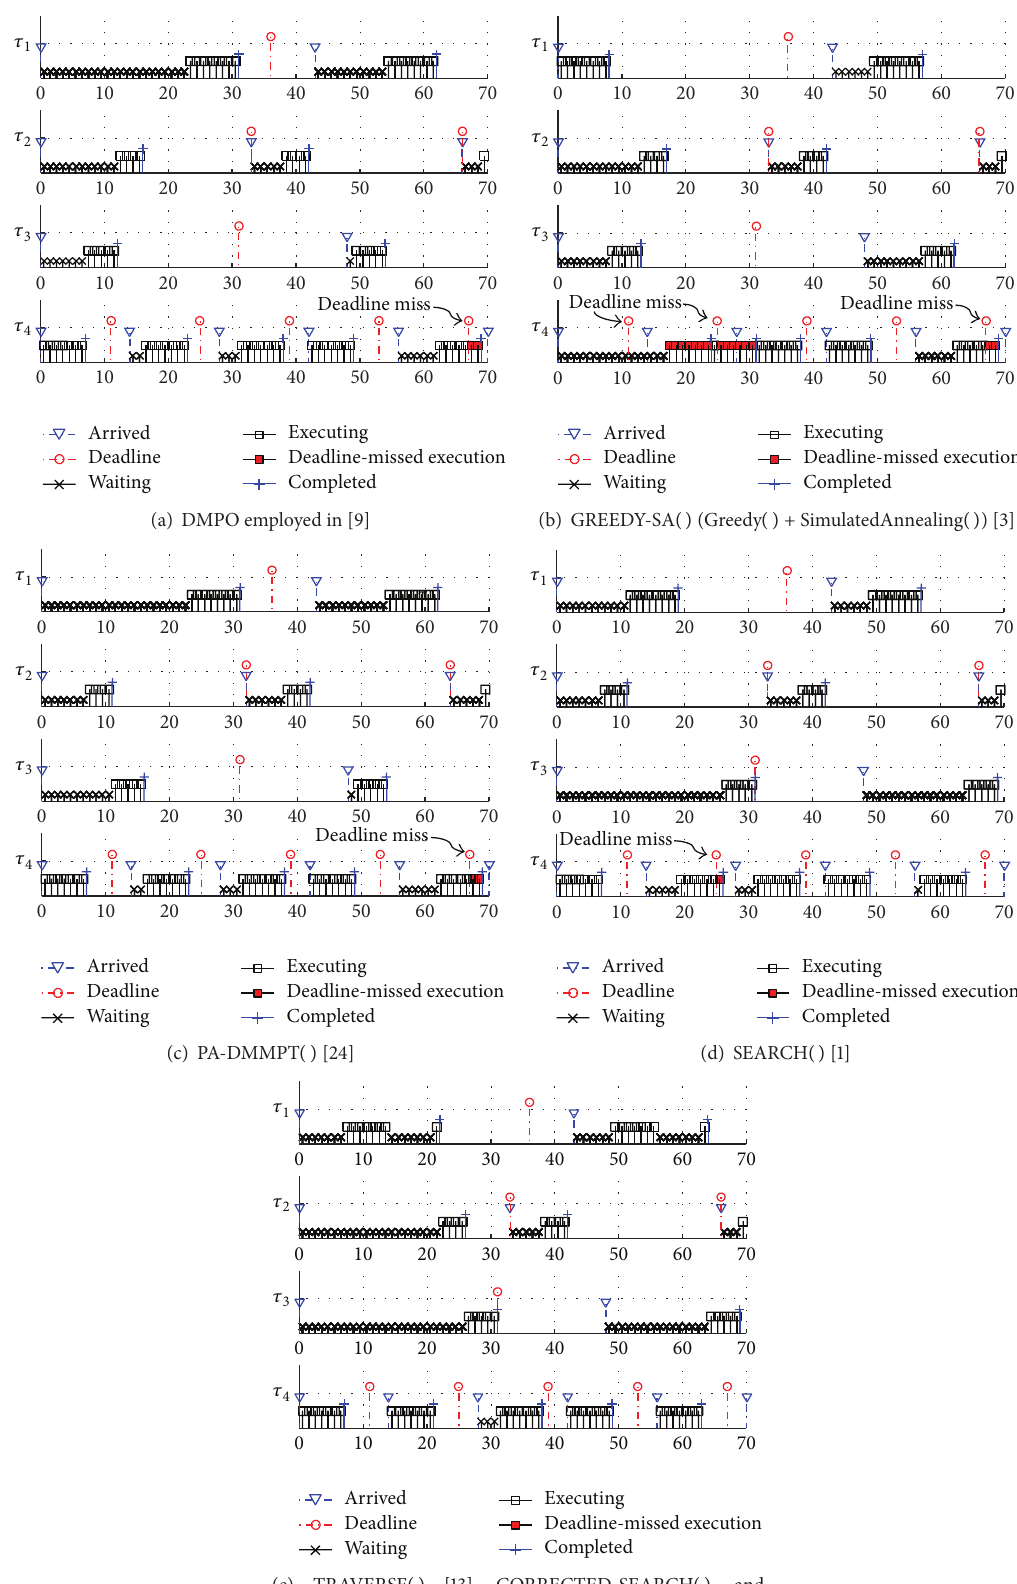
Figure 1: Schedule produced for the walk-through example task set of Table 1 by various priority assignment algorithms. Note that some instances of task 𝜏 4 in (a) ∼ (d) miss their deadlines while every task in (e) does not miss its